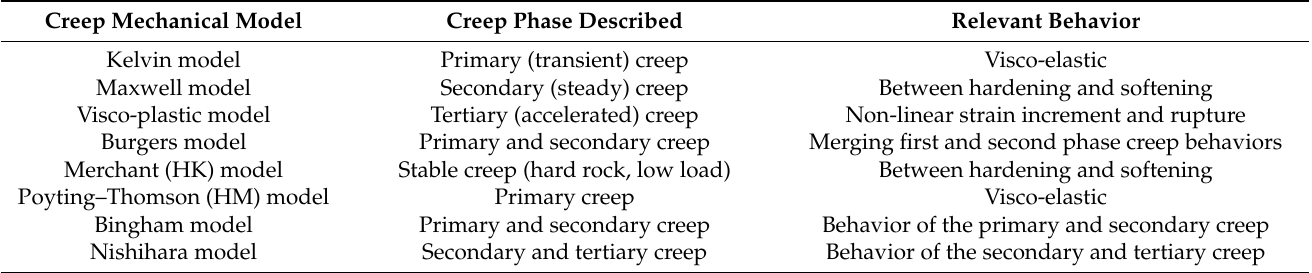
Figure 9. A mechanical model integrating thermo-damage effect (after Chen et al. [97], Copy- right©2022, with permission from the publisher, License No. 5333771474409). 6.2. Constitutive Creep Models of Rocks Creep constitutive models are usually conceived to predict long-term deformations of rocks. They are roughly classified into two types such as empirical equations and dif- ferential creep equations [98]. The differential creep equations can be linear and nonlinear. Nonlinear models are generally established to overcome the limitations of common me- chanical models which are characterized by linear components [79]. The empirical creep equations are generally in the forms of power-law, exponential, logarithmic, and are com- monly derived from typical creep curves. Empirical equations can also be a mixture of the